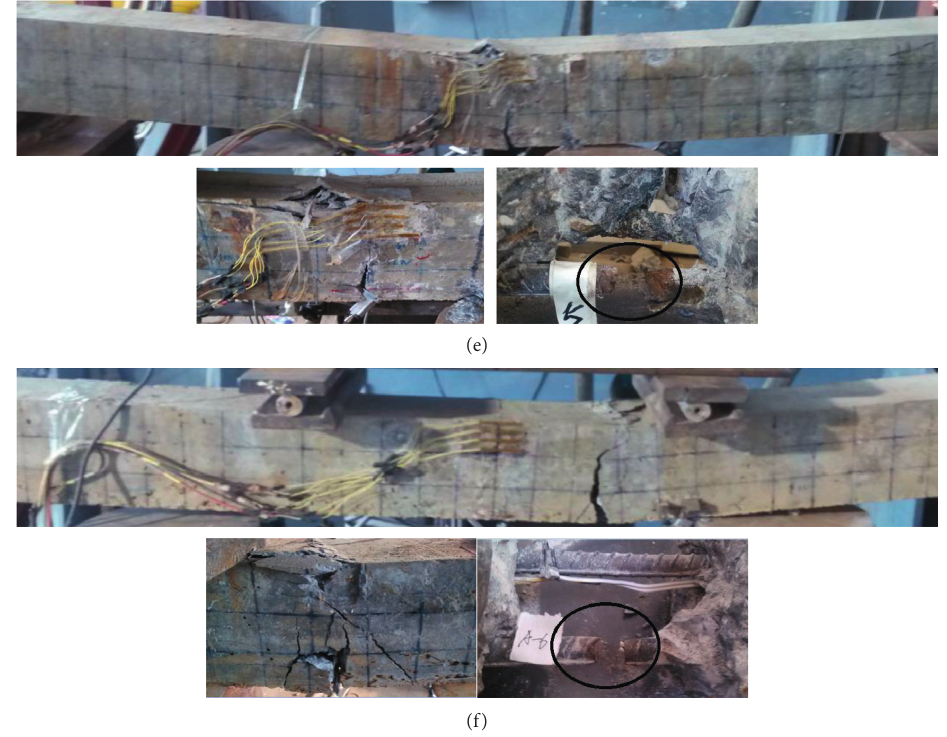
Table 2: Fatigue life of each tested beams.